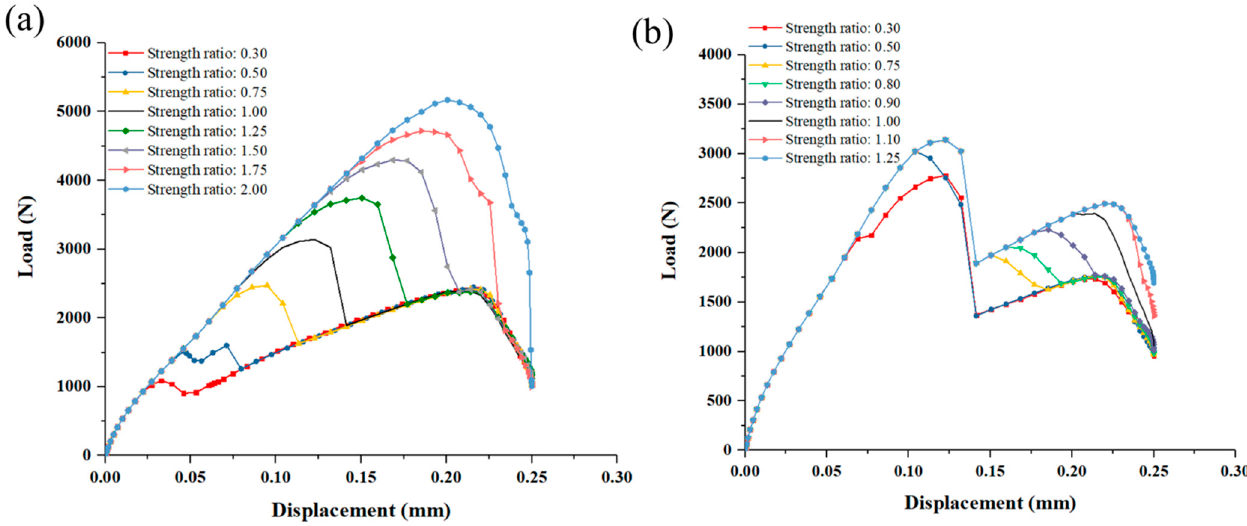
Figure 13. Load and displacement curves of different strength of: ( a ) Deposited SiC matrix in DZA; ( b ) Deposited SiC matrix in DZB.